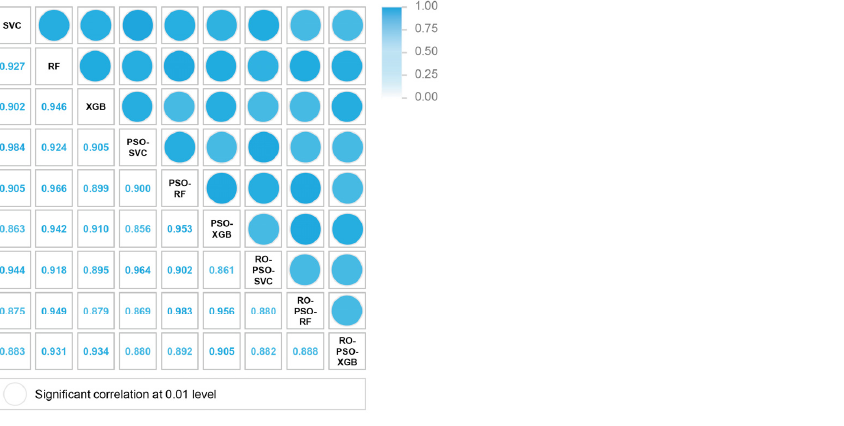
Figure 9. Spatial consistency matrix among the debris flow susceptibility maps.